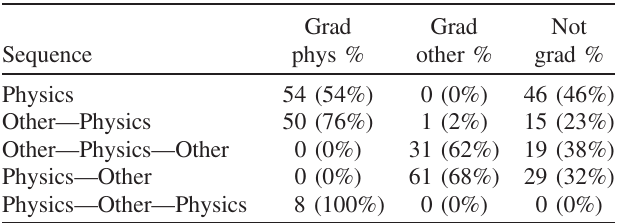
TABLE II. Institution 1 major election sequences. Sequence